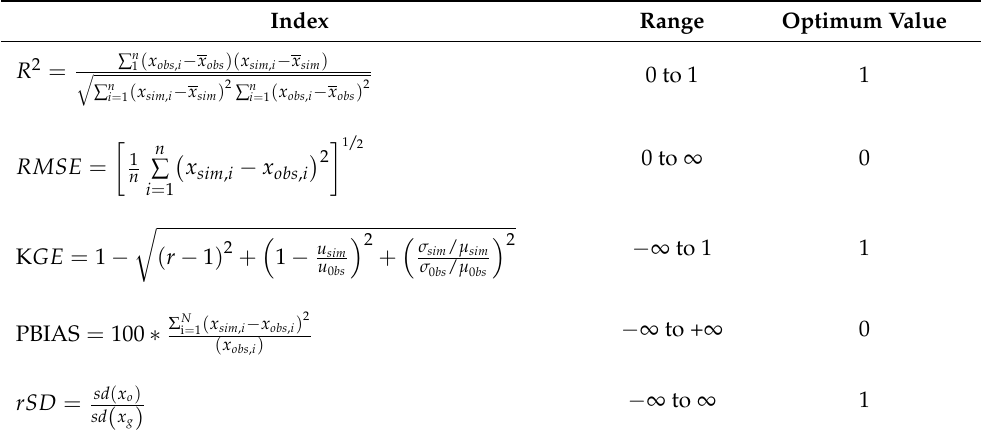
Table 3. Statistical indices used for the performance evaluation of satellite precipitation data. Index